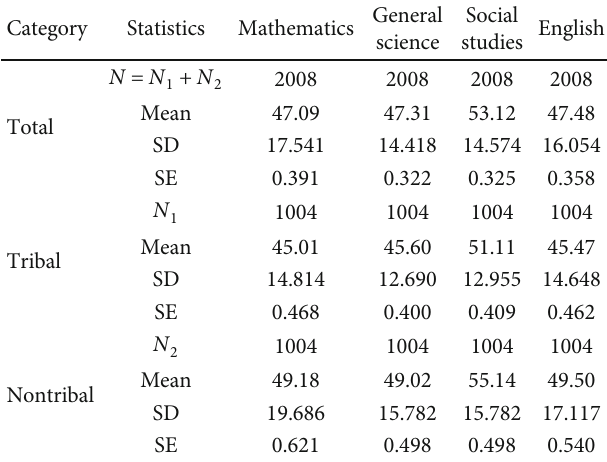
Table 1: The descriptive statistics for total tribal and nontribal